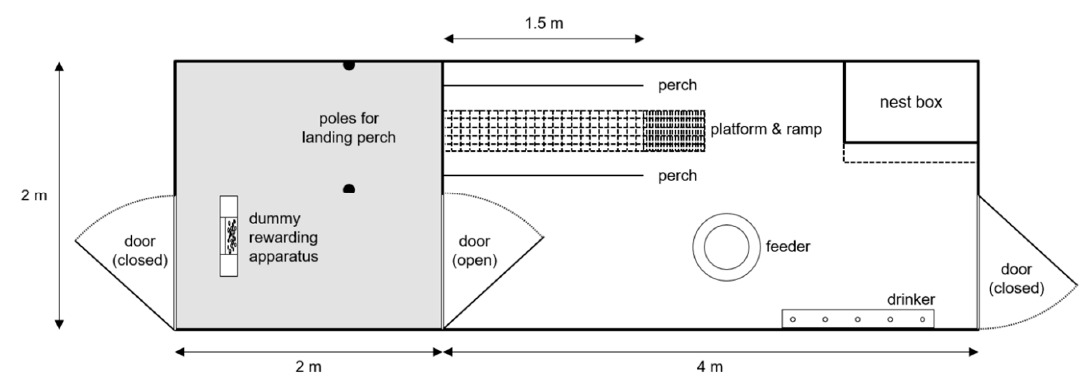
Figure 1. Top view of an experimental pen with test pen (left; gray background) and home pen (right) where hens had access to both pen compartments (i.e., if no training or testing took place). The home pen contained a feeder, nipple drinkers, nest box with landing board, perches, platform, and a ramp leading to the floor. The test pen contained vertical poles which held the landing perch during testing and a dummy rewarding apparatus for habituation.